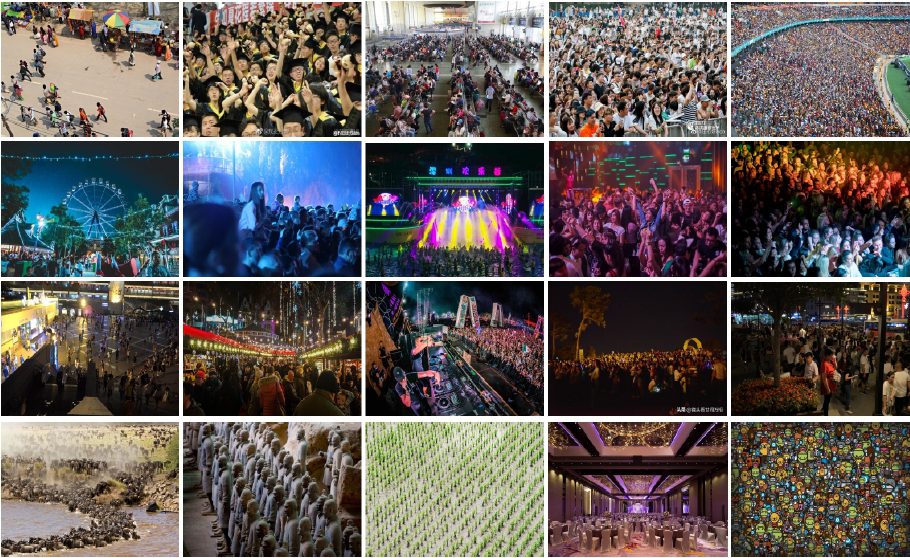
Figure 3. Some sample images from NWPU-counting